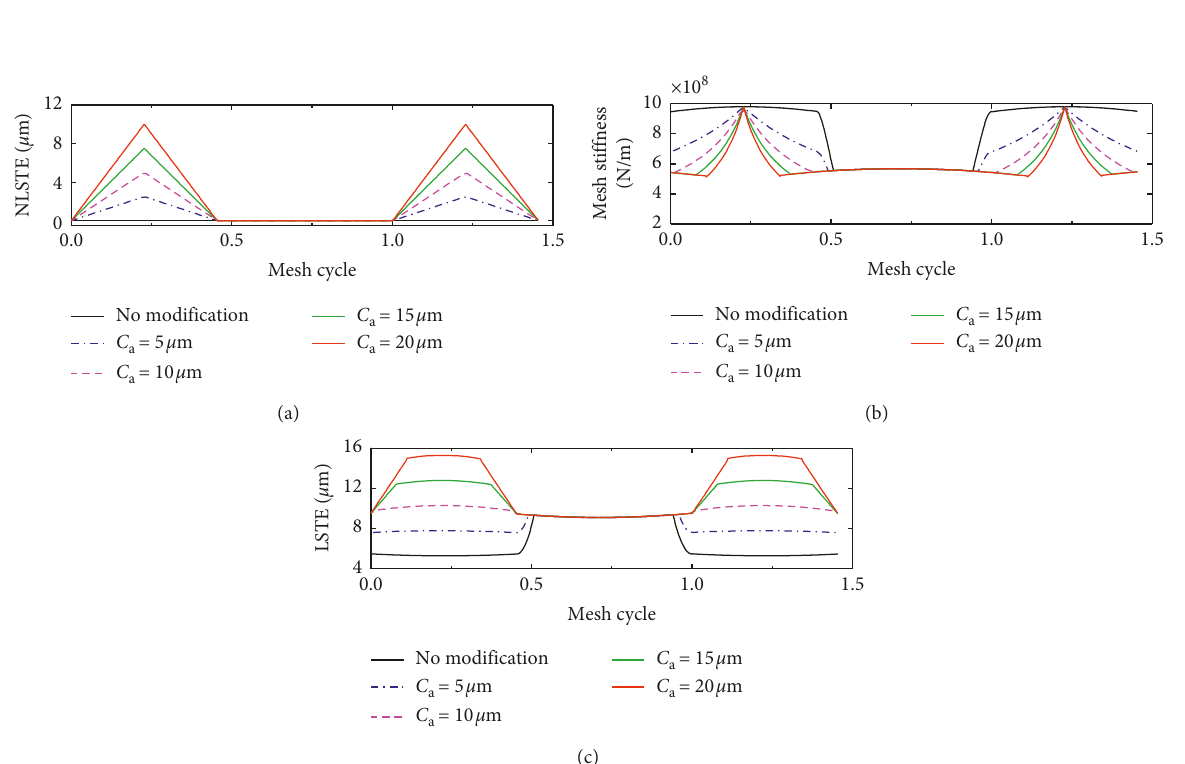
Figure 7: TVMS and TEs of a sun-planet mesh gear pair influence of the amount of TPM: (a) NLSTE, (b) TVMS, and (c) LSTE.